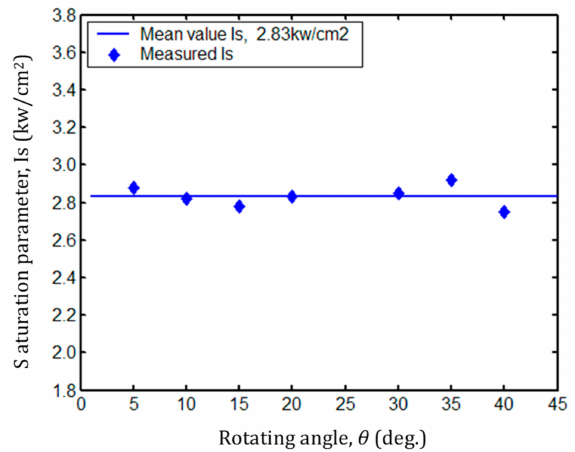
Figure 9. The saturation parameter I S as a function of the rotating angle θ .